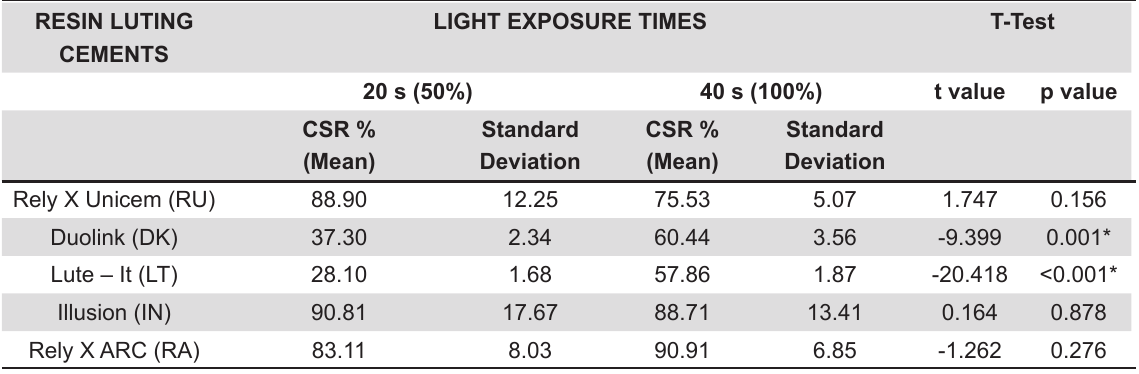
* as compared to the control (cultures without sample) for 20 s and 40